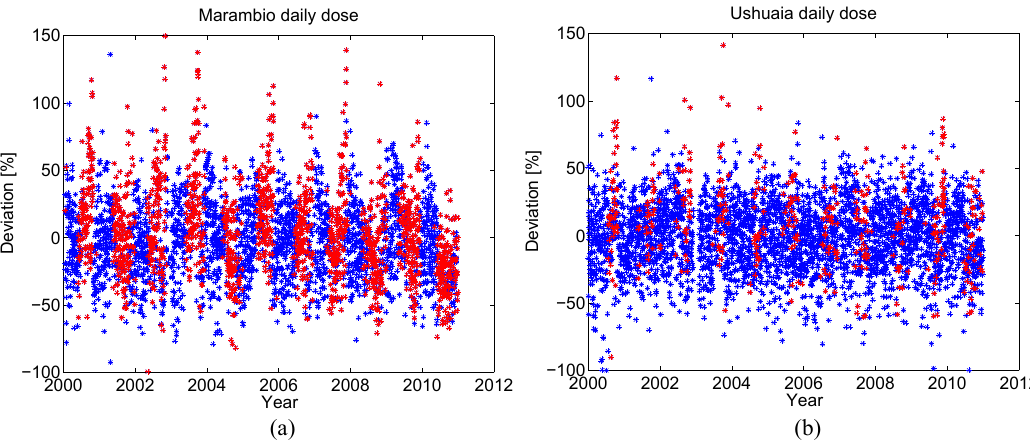
Figure 13. Deviations from the daily climatology of erythemal daily doses in (a) Marambio and (b) Ushuaia for the years 2000–2010. Days for which the station was inside the polar vortex are indicated with red symbols, the others in